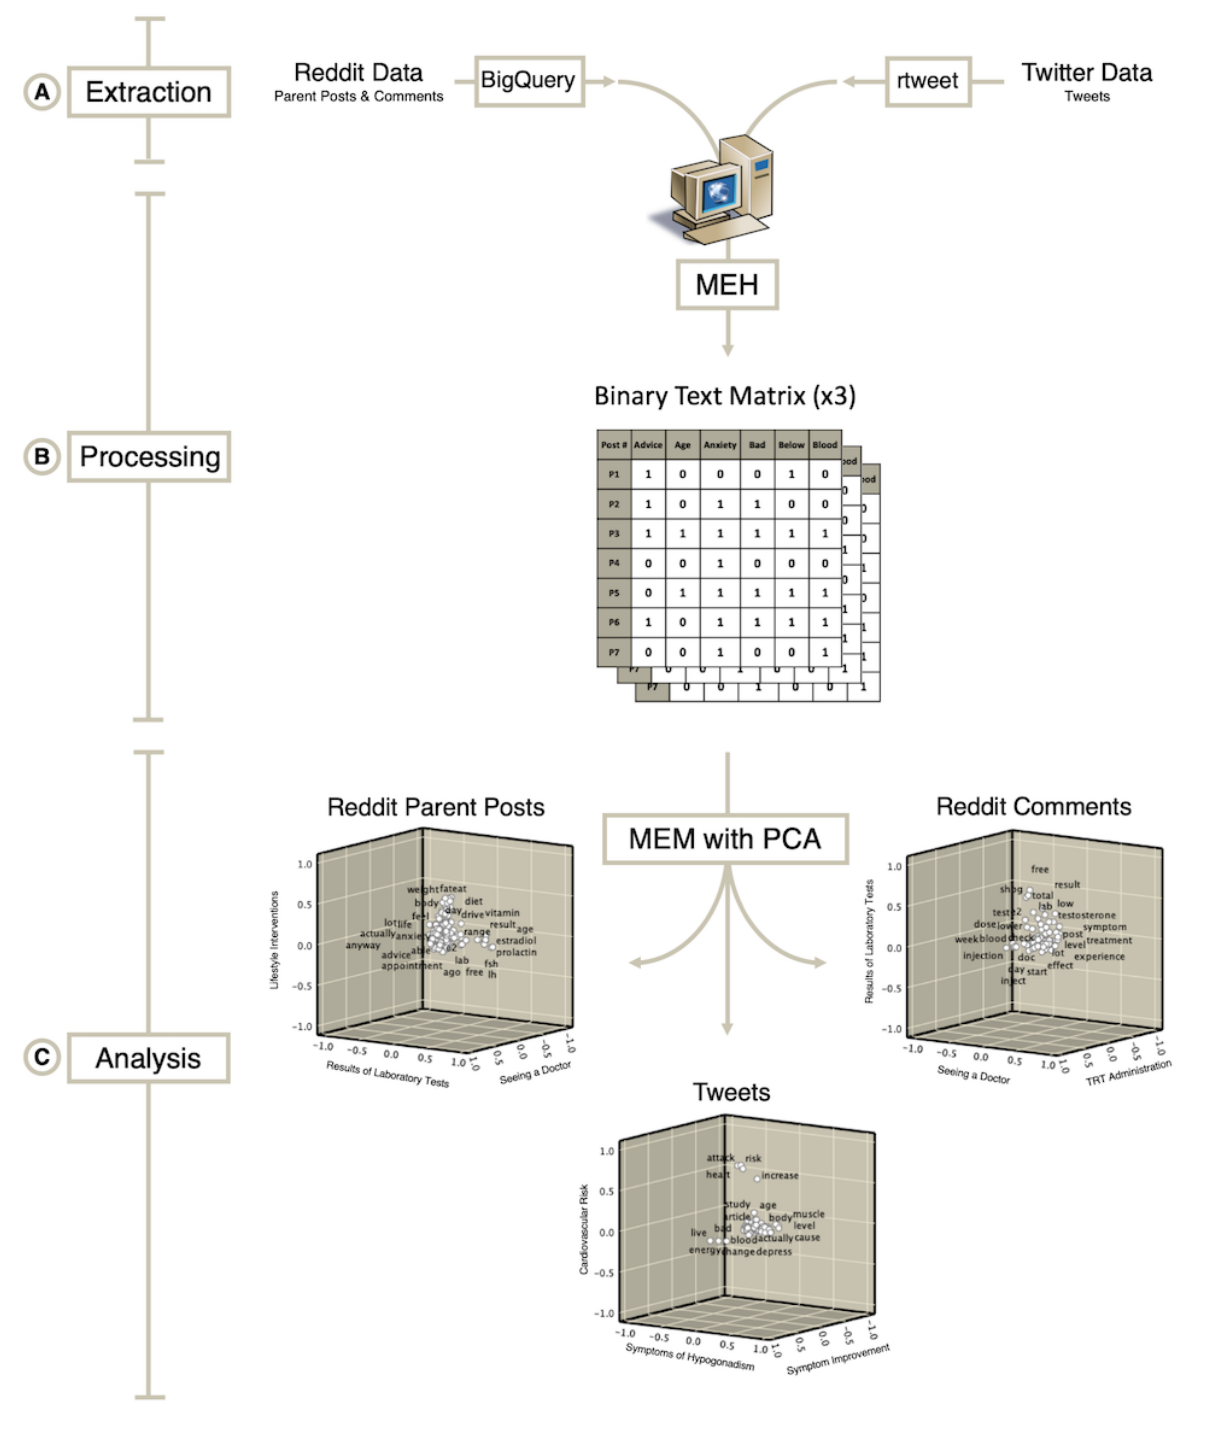
Figure 1. Overview of methods: (A) extraction of Reddit and Twitter data using BigQuery and rtweet, respectively; (B) processing of raw text data using the meaning extraction helper to generate a binary text matrix for each data set; (C) meaning extraction method with principal component analysis generates word clusters for each dataset. Rotated component plots are shown with x-, y-, and z-axes representing the three clusters that capture the greatest variance of the data. MEH: meaning extraction helper; MEM: meaning extraction method; PCA: principal component